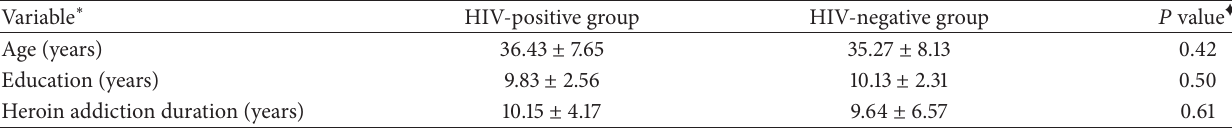
Table 1: Age, education, and duration of heroin addiction among HIV-positive and HIV-negative participants of the study.